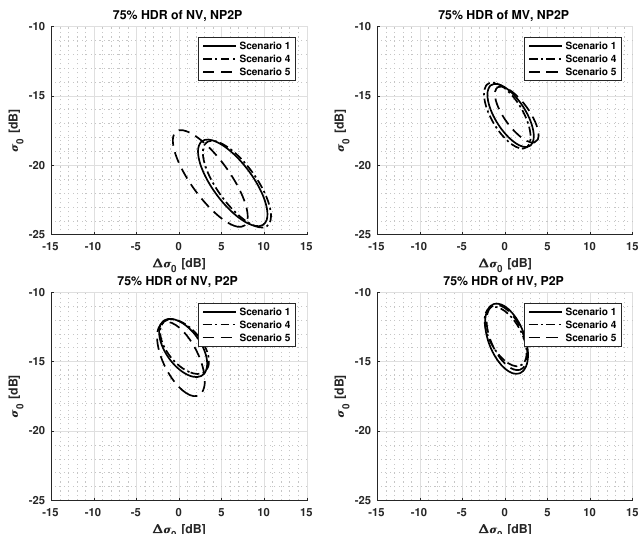
Figure 8. The 75% HDR plots for NV for NP2P and P2P for Scenarios 1, 4 and 5.